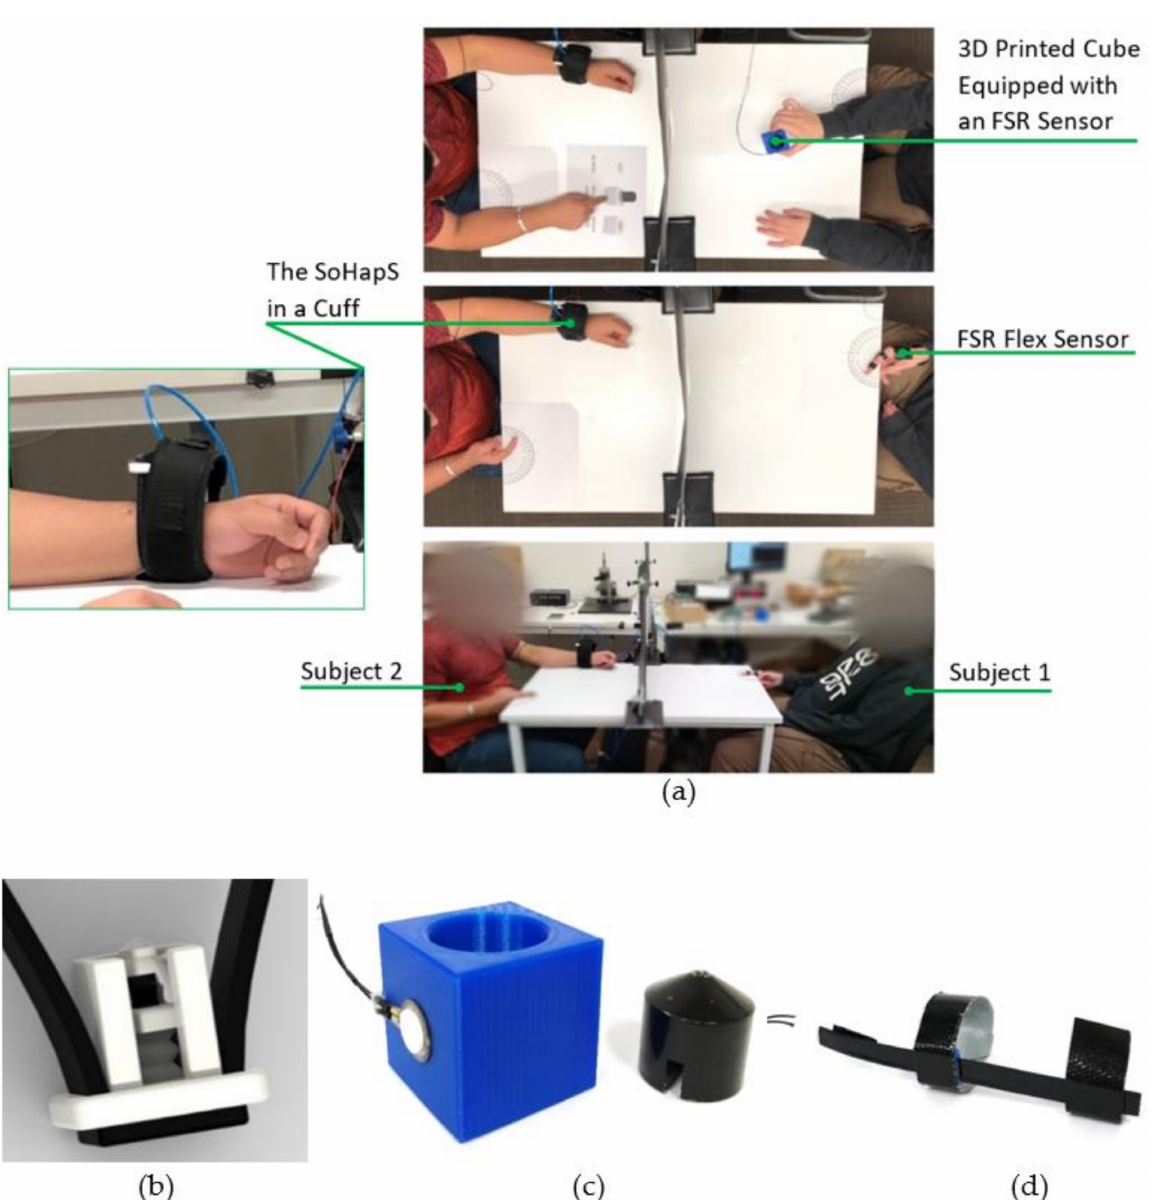
Figure 12. Experimental setup for ( a ) testing SoHapS in delivering substitute tactile feedback to communicate gripping force and proprioceptive feedback to communicate finger position (i.e., flexion– extension). ( b ) Three-dimensional CAD model of SoHapS with custom-designed housing and soft strap, ( c ) 3D-printed gripping force cube equipped with an FSR sensor, and ( d ) a flex sensor worn on the index finger by